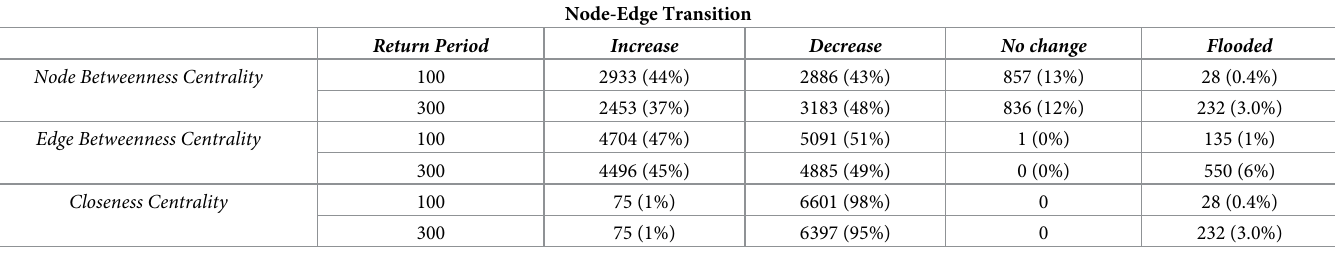
Table 1. Changes in the number of nodes from the peak scenario for normalized node betweenness centrality and closeness centrality, and changes in the number of edges for the normalized edges betweenness